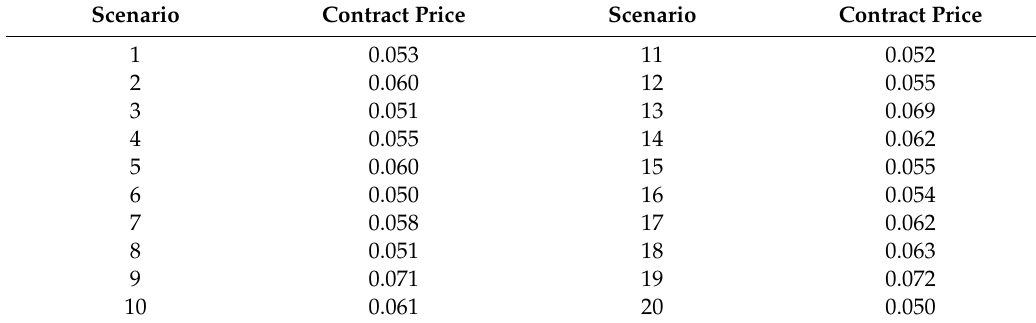
Table 4. Calculated contract price via goal programming (GP).